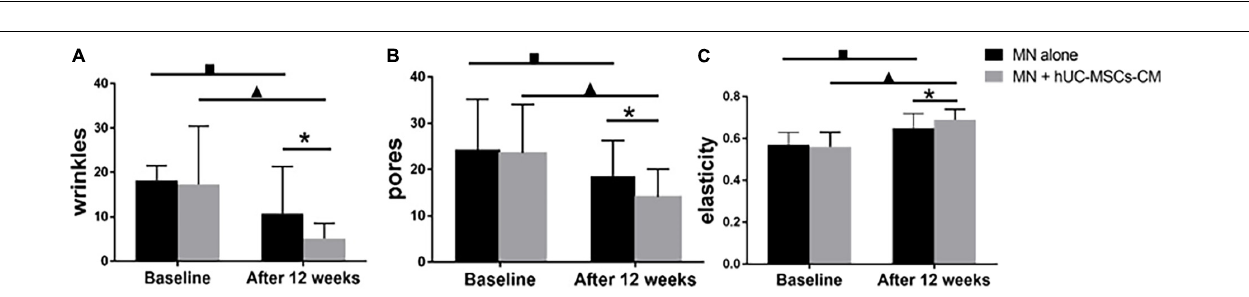
Frontiers in Medicine |